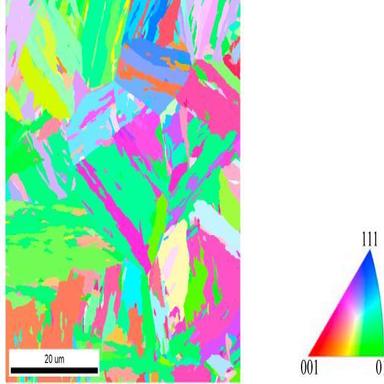
Martensitic microstructure formed out of approximately 15 former austenitic grains after assigning a single orientation to each (sub-)block. Color indicates crystallographic orientation in Inverse Pole Figure (IPF) notation parallel to the out-of-plane direction. (For interpretation of the references to color in this figure, the reader is referred to the web version of this article.)